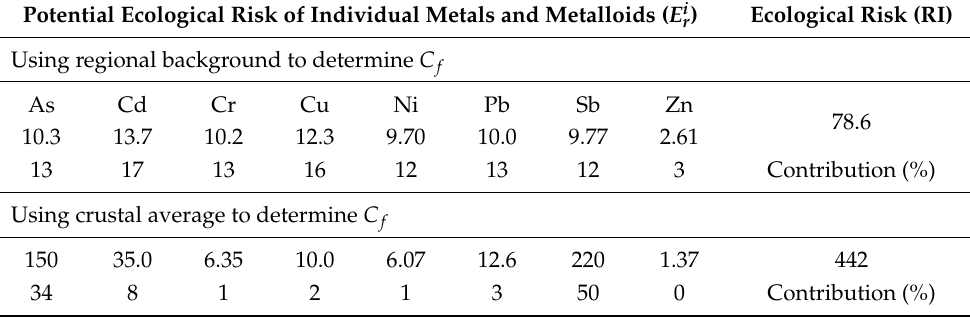
Table 4. General E i r values determined for the PTEs in the studied samples and the correspondent RI values determined based on elemental crustal averages and the determined regional background. Potential Ecological Risk of Individual Metals and Metalloids ( E i r ) Ecological Risk (RI) Using regional background to determine C